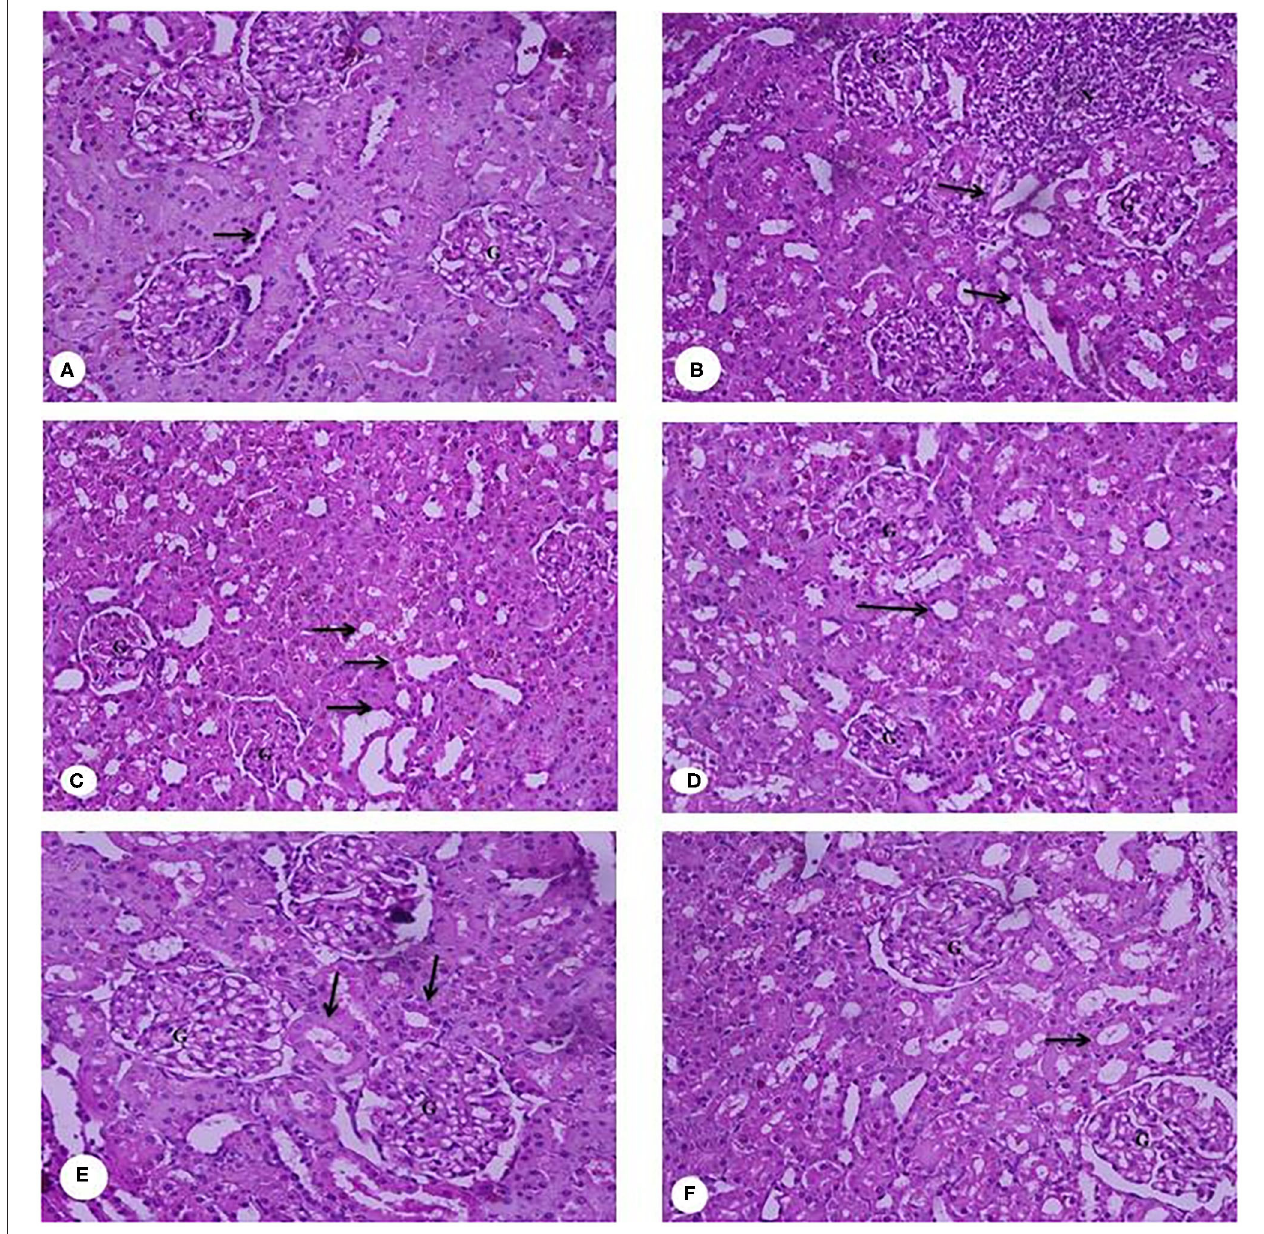
FIGURE 9 | (A–F) Representative photomicrographs of kidney sections of rats from the different experimental groups (Hematoxylin and eosin stain X 40). (A) G1 Negative control. (B) G2 Positive control group. (C) G3 Fed SFY fortified with free Fe + ascorbic acid. (D) G4 Fed SFY fortified with free Fe + FA + ascorbic acid. (E) G5 Fed SFY fortified with Fe@ BSA-NPs + ascorbic acid. (F) G6 Fed SFY fortified with Fe + FA@ BSA-NPs + ascorbic acid. BSA-NPs, Bovine Serum Albumin nanoparticles; FA, Folic